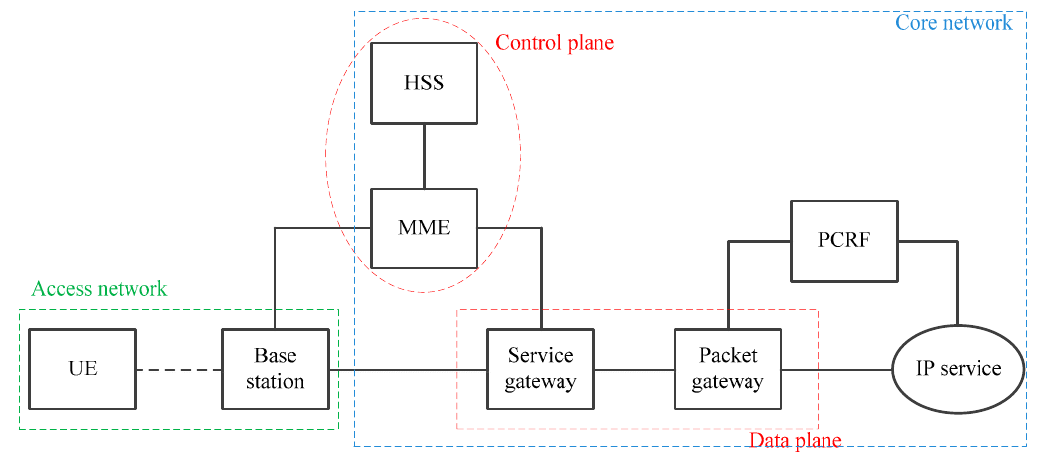
Figure 3. The structure of the traditional LTE system.